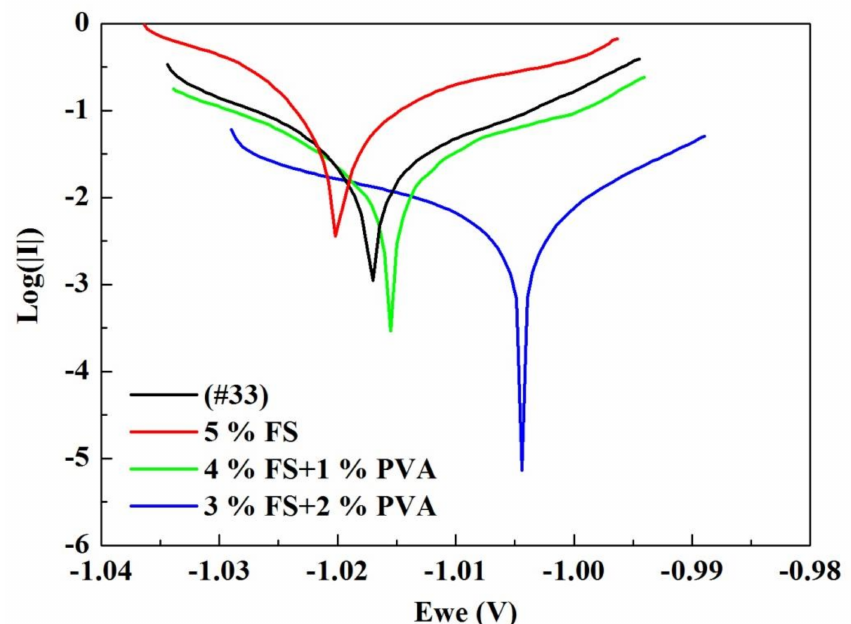
Figure 1. Linear polarisation observed when the zinc working electrode is in contact with different electrolytes.